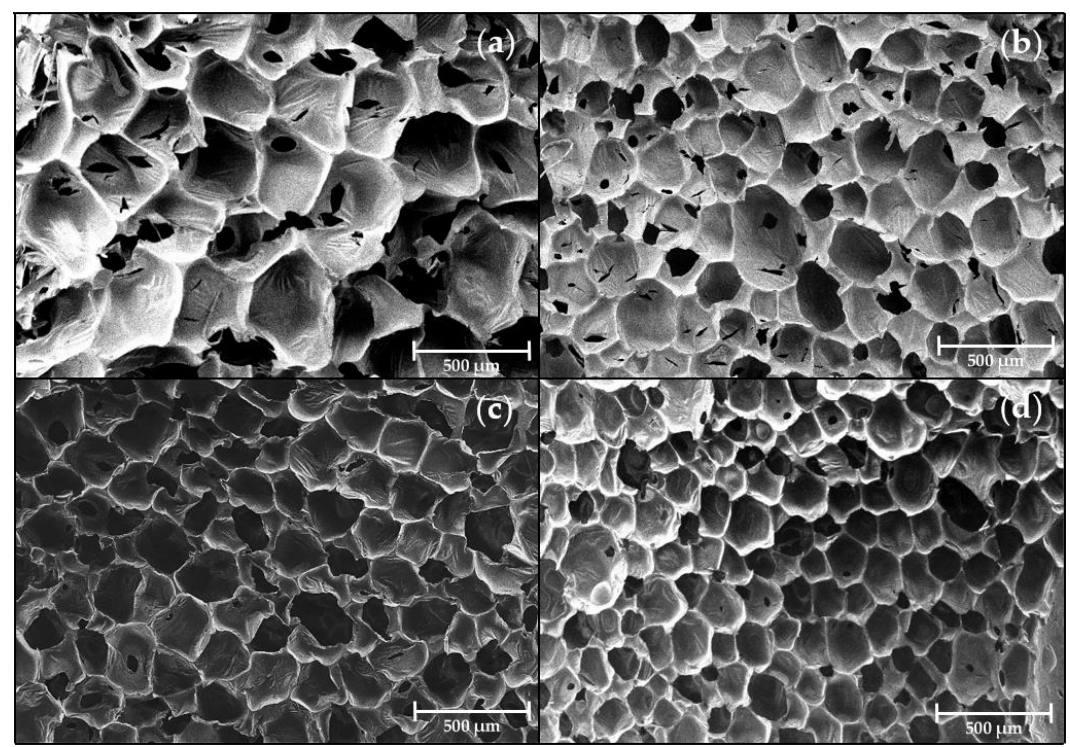
Figure 5. SEM image of prepared foams, ( a ) N, ( b ) C0.25, ( c ) C0.5, and ( d ) C1.